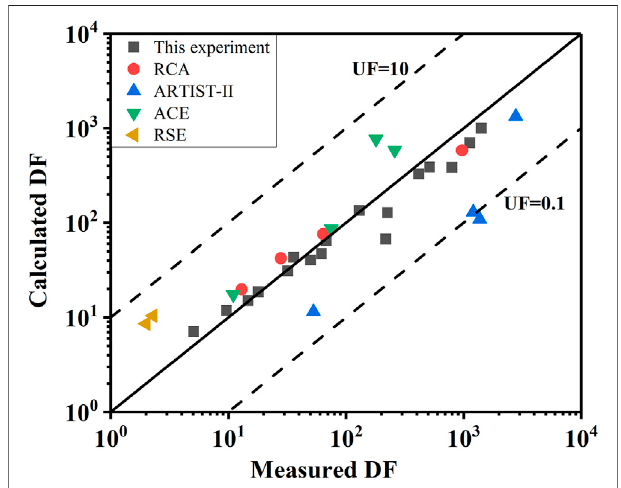
FIGURE 13 | Comparison between the calculated DF and the experimental